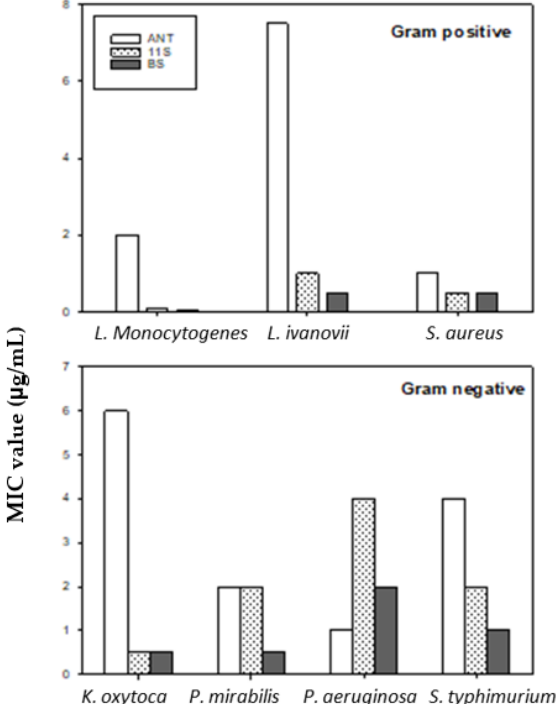
Figure 8. Comparison of MICs of tested lupine (11S globulin and BS) with specific antibiotics for each microorganism.